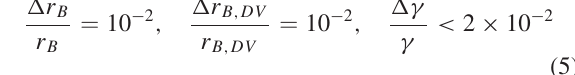
· t (cid:7) 2 / m 2 p p p